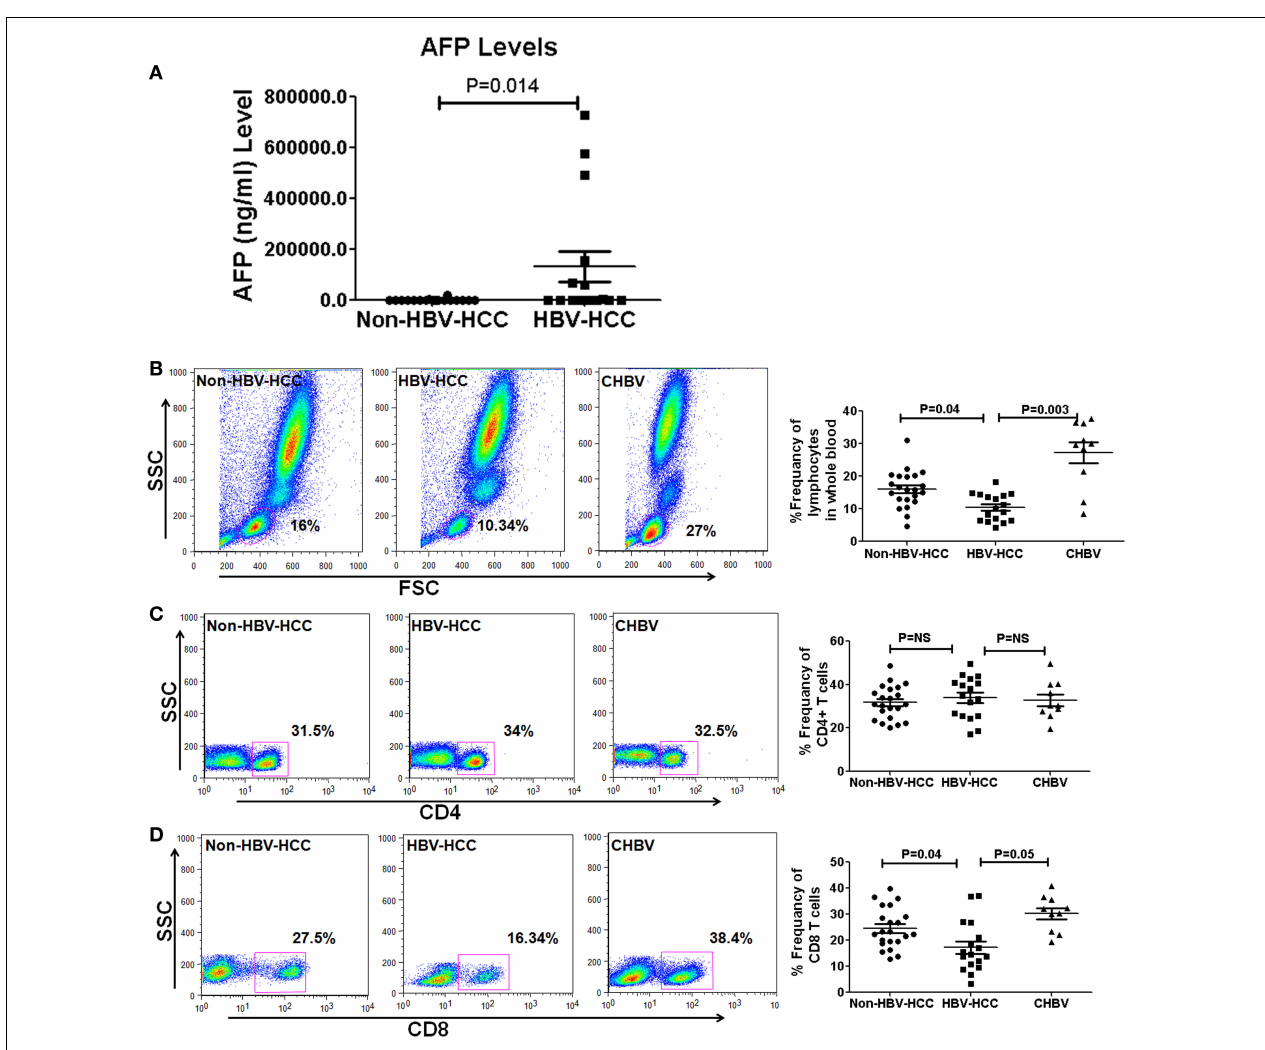
total lymphocytes, CD4, and CD8T cells.Total lymphocyte counts and CD8 + T cells were decreased in HBV-HCC than non-HBV-HCC and CHBV.There was no significant difference in CD4 + T cell counts in between all the three